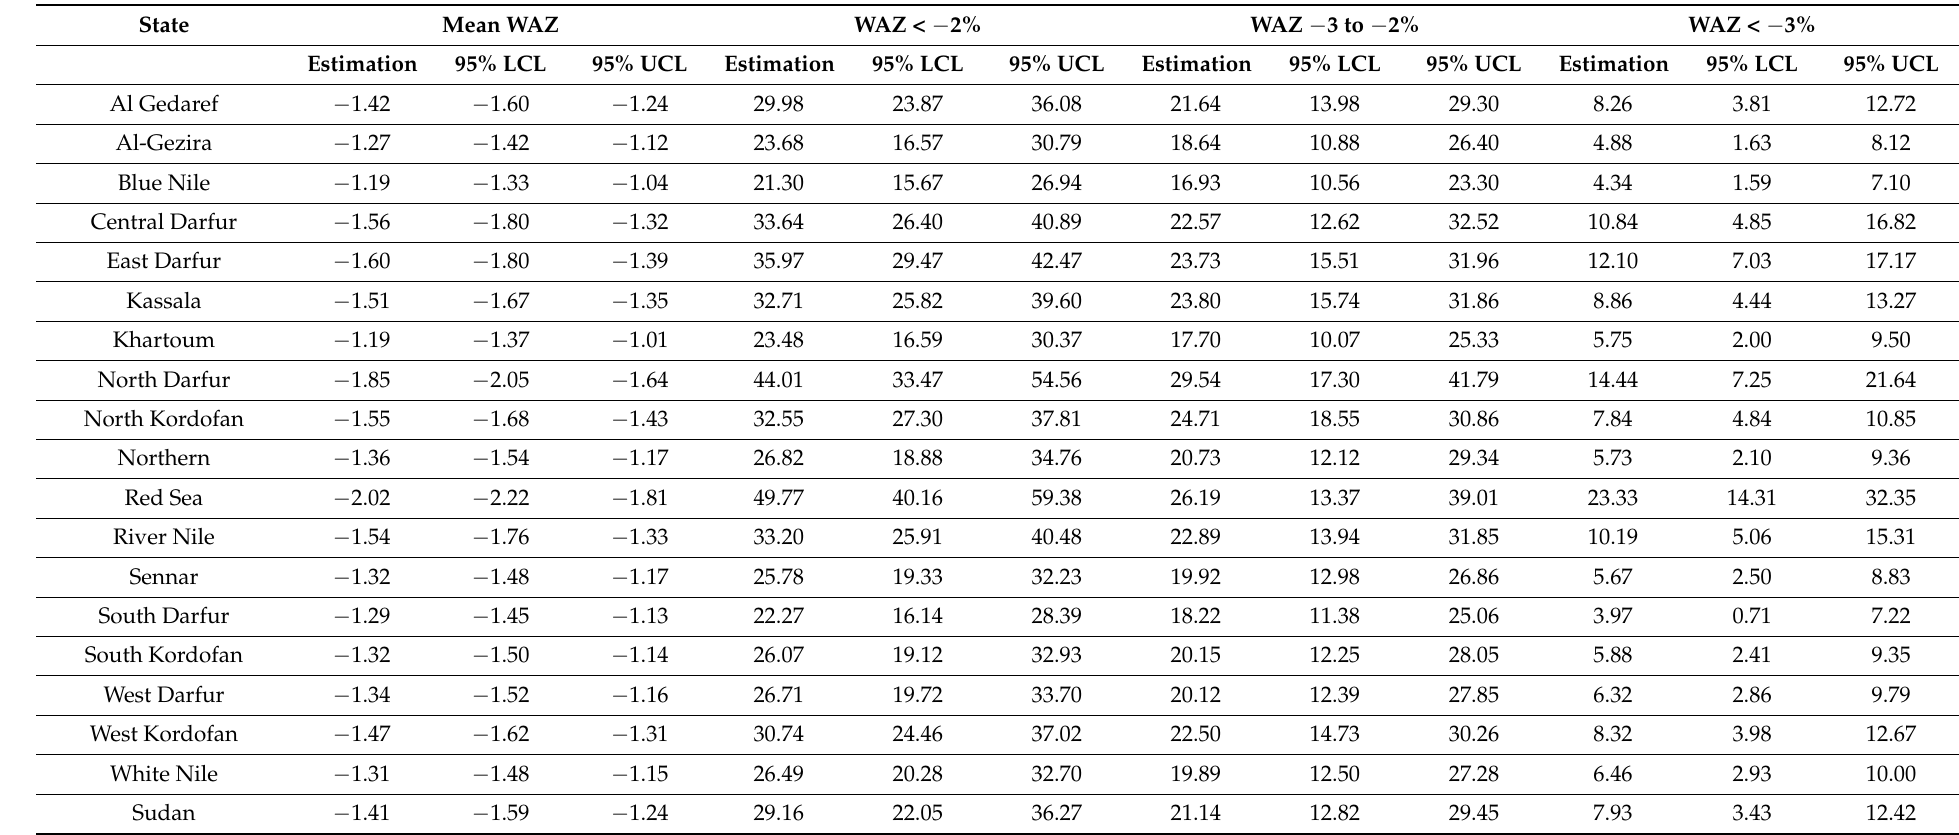
Table 3. Distribution of underweight prevalence and mean by